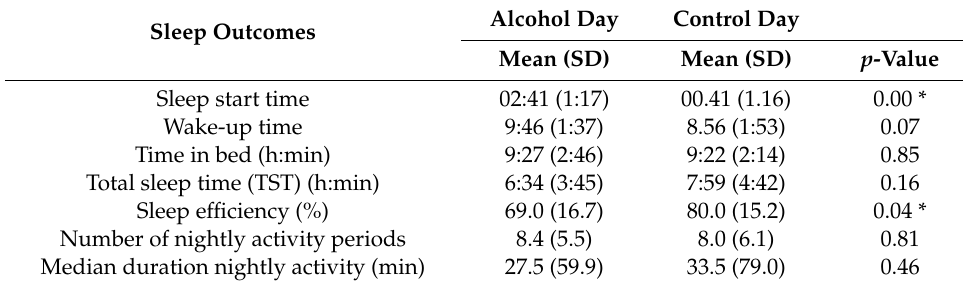
Table 2. GENEactiv sleep